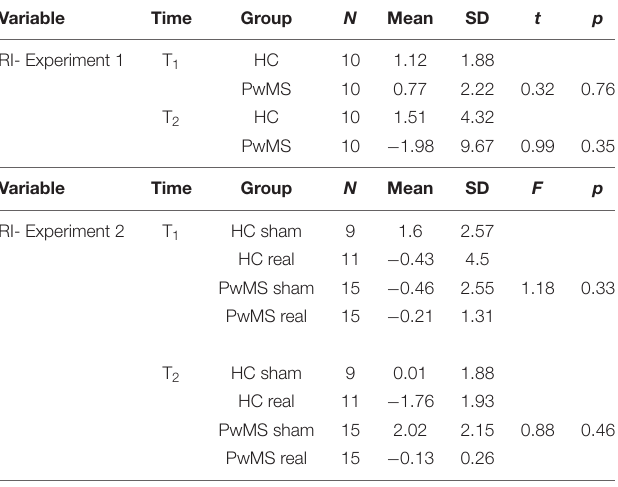
TABLE 3 | Comparison of the in retention index (RI) between the groups (Student t -test for independent samples in experiment 1, one-way ANOVA in experiment 2).